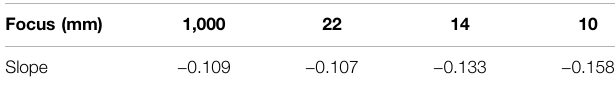
TABLE 1 | The slope of linear contrast curves at different focal